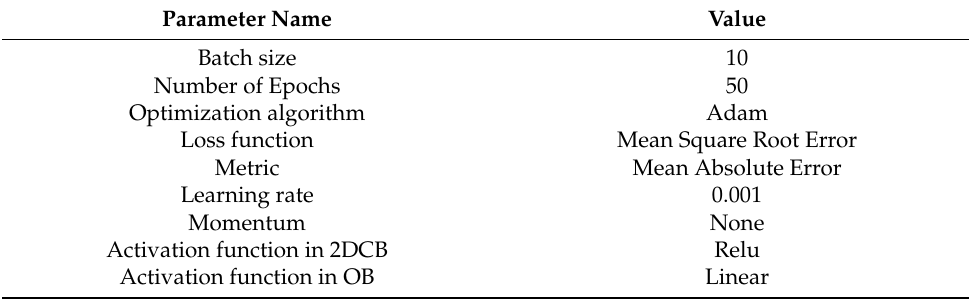
Table 3. Hyperparameters